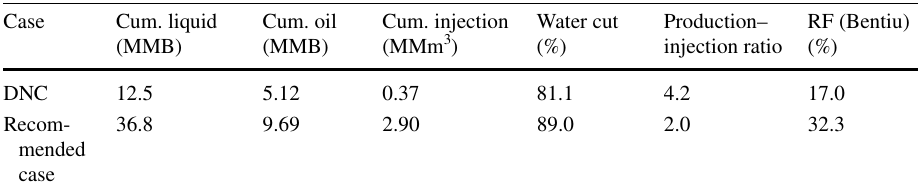
Table 18 Forecast result